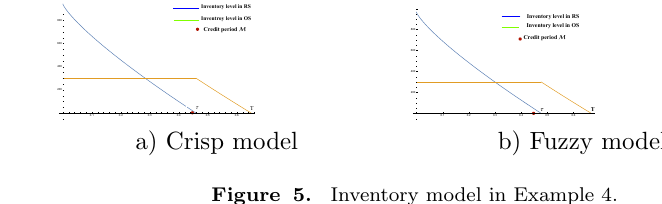
Figure 5. Inventory model in Example 4.